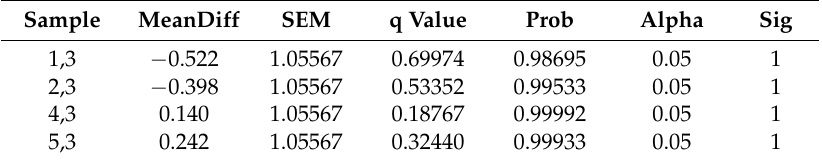
Table 2. Tukey test of the EMCs of the composites along the moisture adsorption direction. Sample